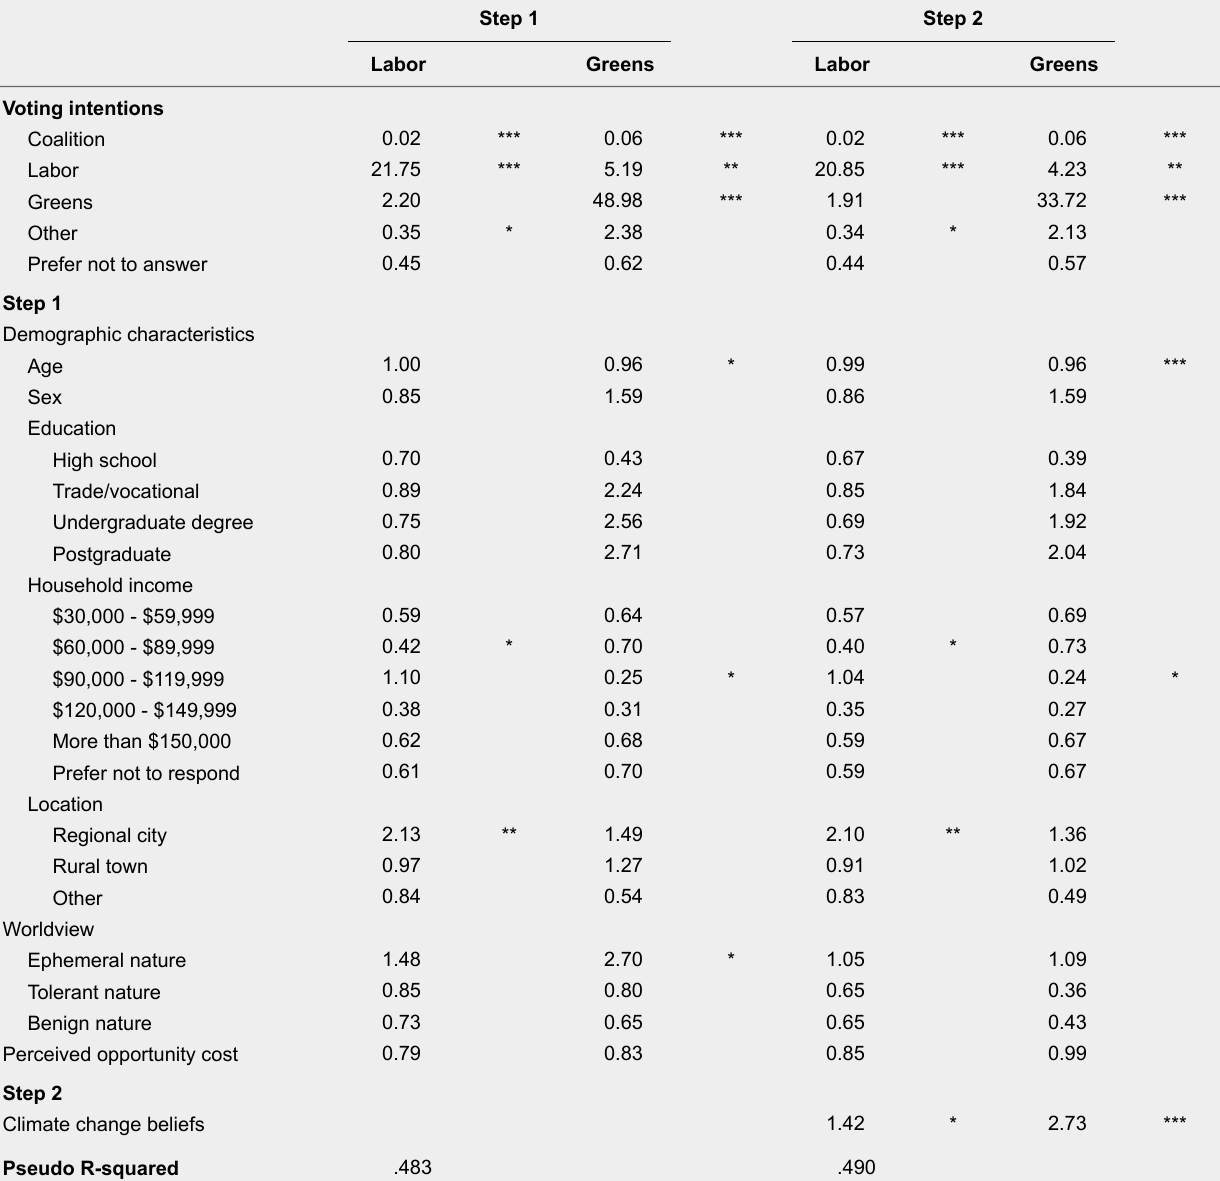
Relative Risk Ratios (RRR) for Voting Swings to Labor or the Greens Compared to the